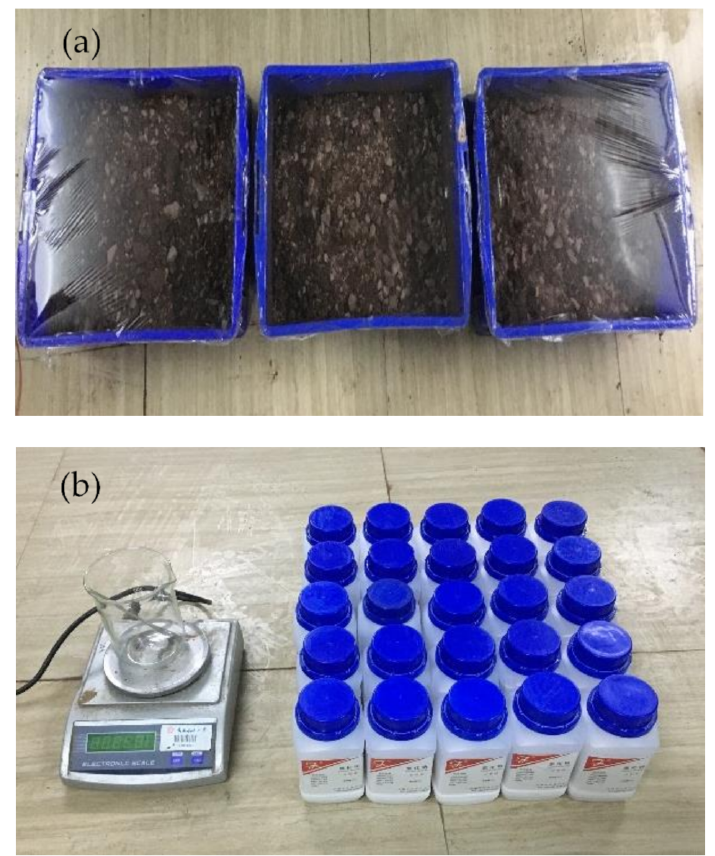
Figure 4. Preparation of SRM and solution. ( a ) SRM mixed with water and sealed. ( b ) NaCl white crystalline